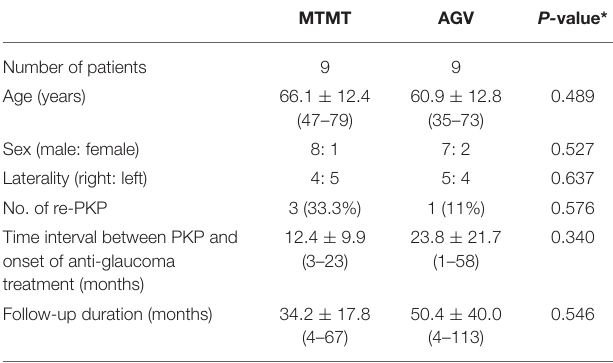
TABLE 1 | Demographics of the patients in the MTMT and AGV